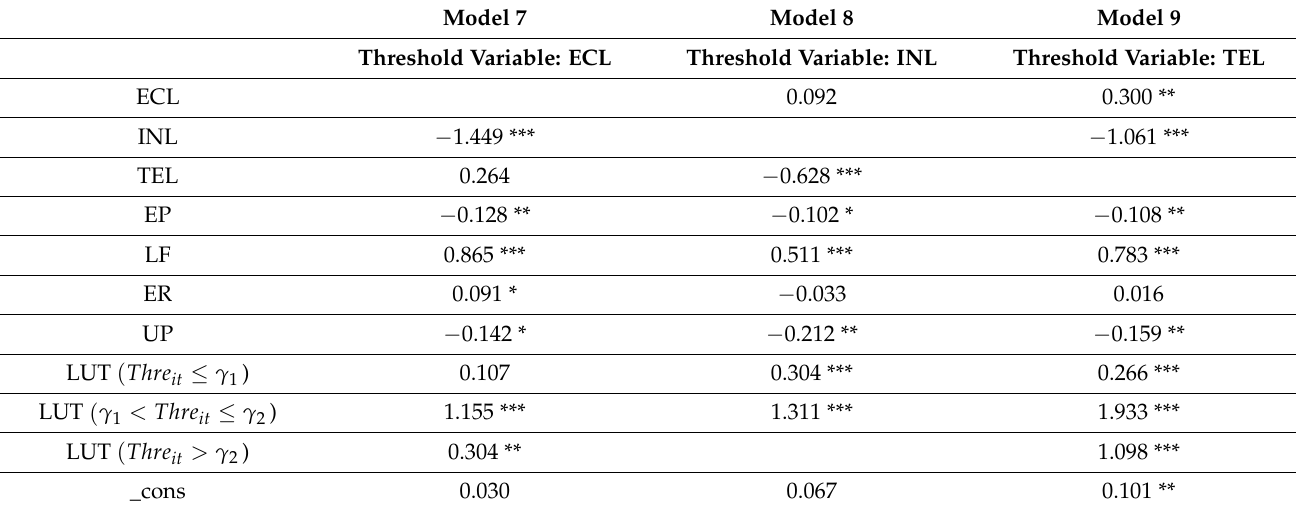
Table 8. Estimation of threshold effect of net carbon